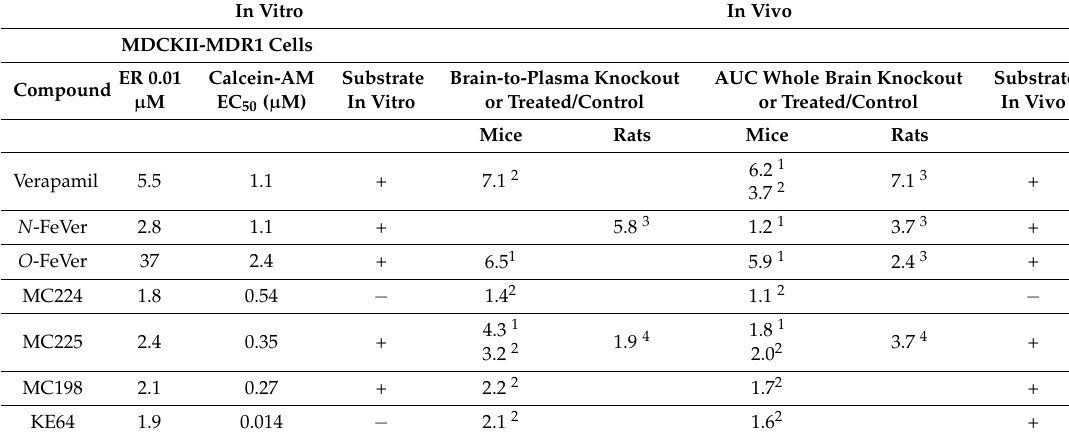
Table 1. In vitro and in vivo results of the P-gp radiotracers tested.